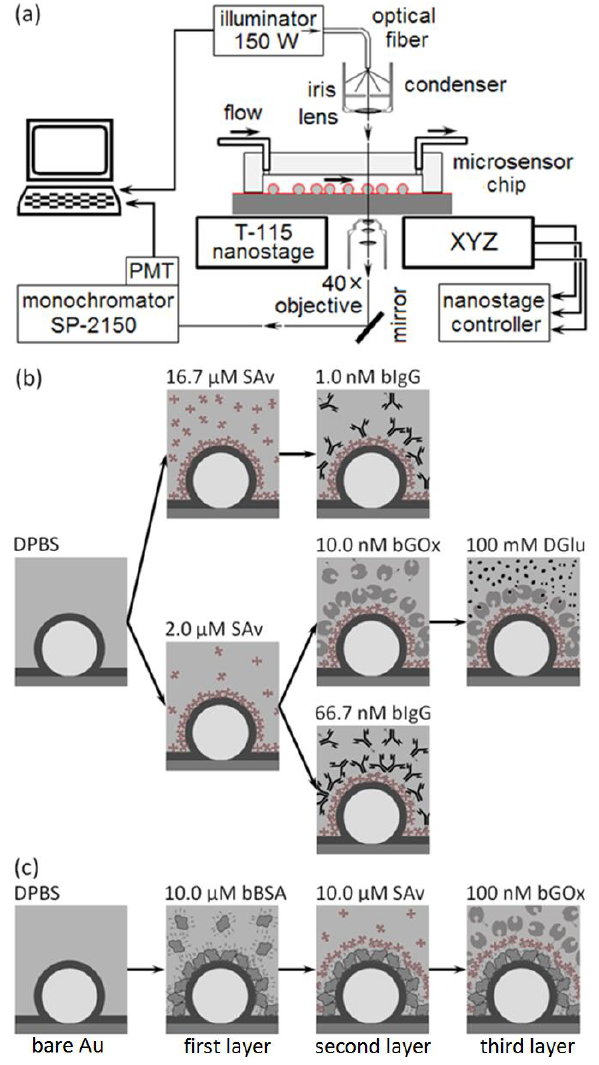
Figure 3. ( a ) Experimental setup: We selected a single microsensor to image using the nano-precision controller stage and analyzed its emitted light using a software-controlled spectrometer. ( b ) Flowchart of a typical target-ligand interaction: the first step shows the formation of the gold-SAv layer, the second the formation of gold-SAv-bIgG and gold-SAv-bGOx layers and the third the interaction of bGOx with DGlu (gold-SAv-bGOx-DGlu). This particular experiment used three different microsensors. ( c ) Flowchart of crosslinker-target-ligand interaction: the first step shows the formation of the gold-bBSA layer, the second the formation of the gold-bBSA-SAv layer and the third the formation of the gold-bBSA-SAv-bGOx layer. In this experiment, the same microsensor monitored all three interactions. Not to